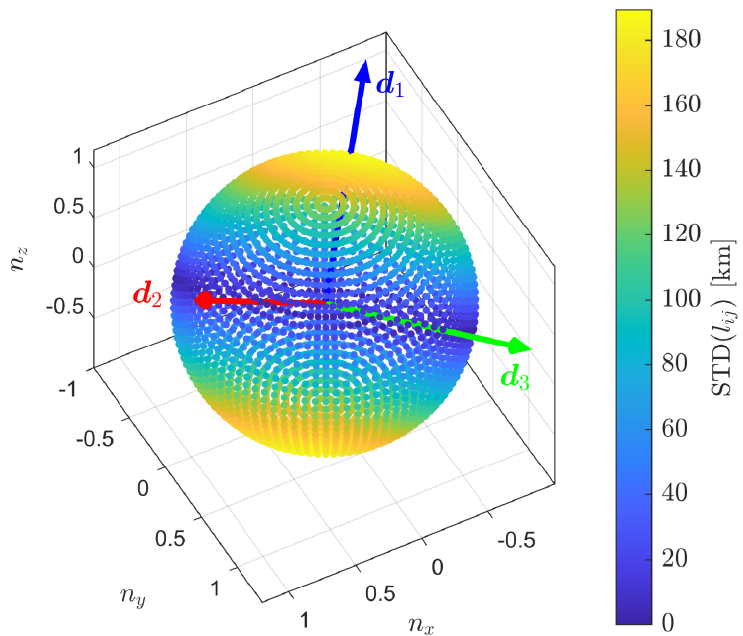
Figure 8. The effects of the position insertion errors of SC1 on the configuration stability. d 1 , d 2 and d 3 represent the radial, the tangential and the normal directions,